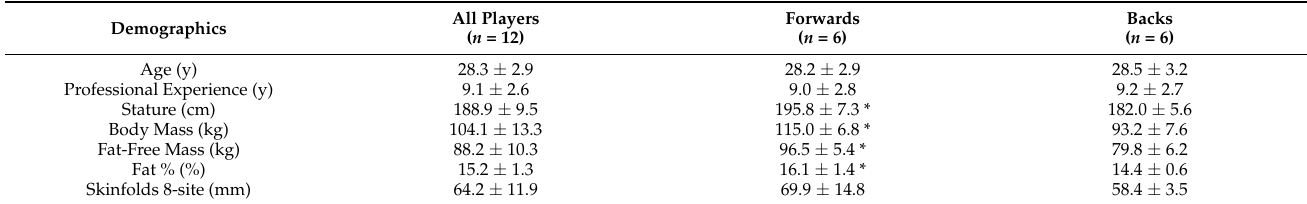
Table 2. Player demographics and body composition.